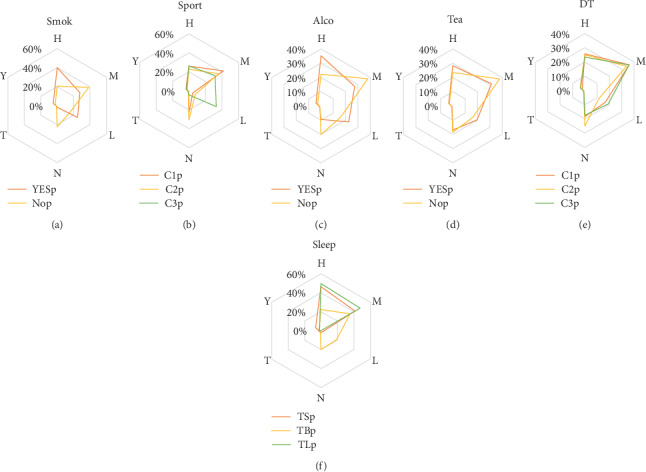
Radar charts illustrating the effects of daily life habits on risk factors of stroke.